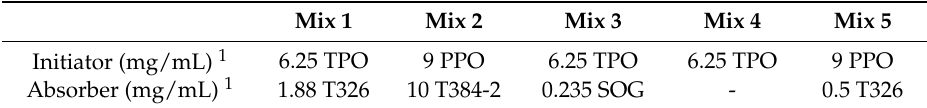
Table 1. Composition of printing formulations mix